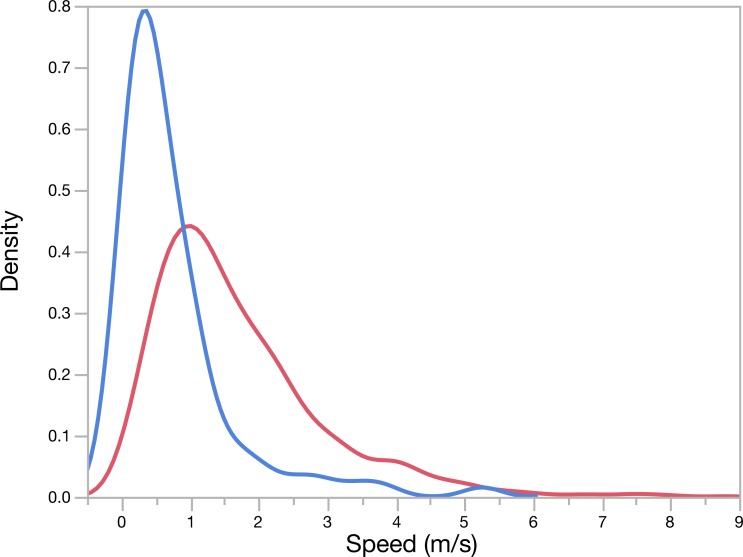
GPS-derived pursuit and escape speeds for hounds (red) and pumas (blue), respectively, during all chases.The mean (±SE) speeds, in m/s, for hounds (1.7 ± 0.03) and pumas (0.74 ± 0.09) are depicted as dashed vertical lines.